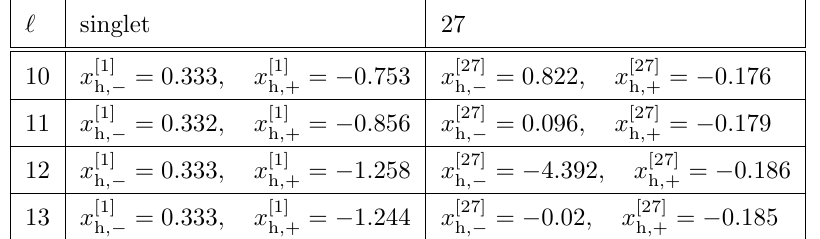
Table 2 . Table summarising the values of x = (cid:11) s L at the poles of the Pad(cid:19)e Approximants in (cid:25) eq. (6.16), considering the hard component of the infrared-renormalized amplitude (indicated by the subscript h) at orders ‘ = 10 through 13 for the singlet and the 27 representation.